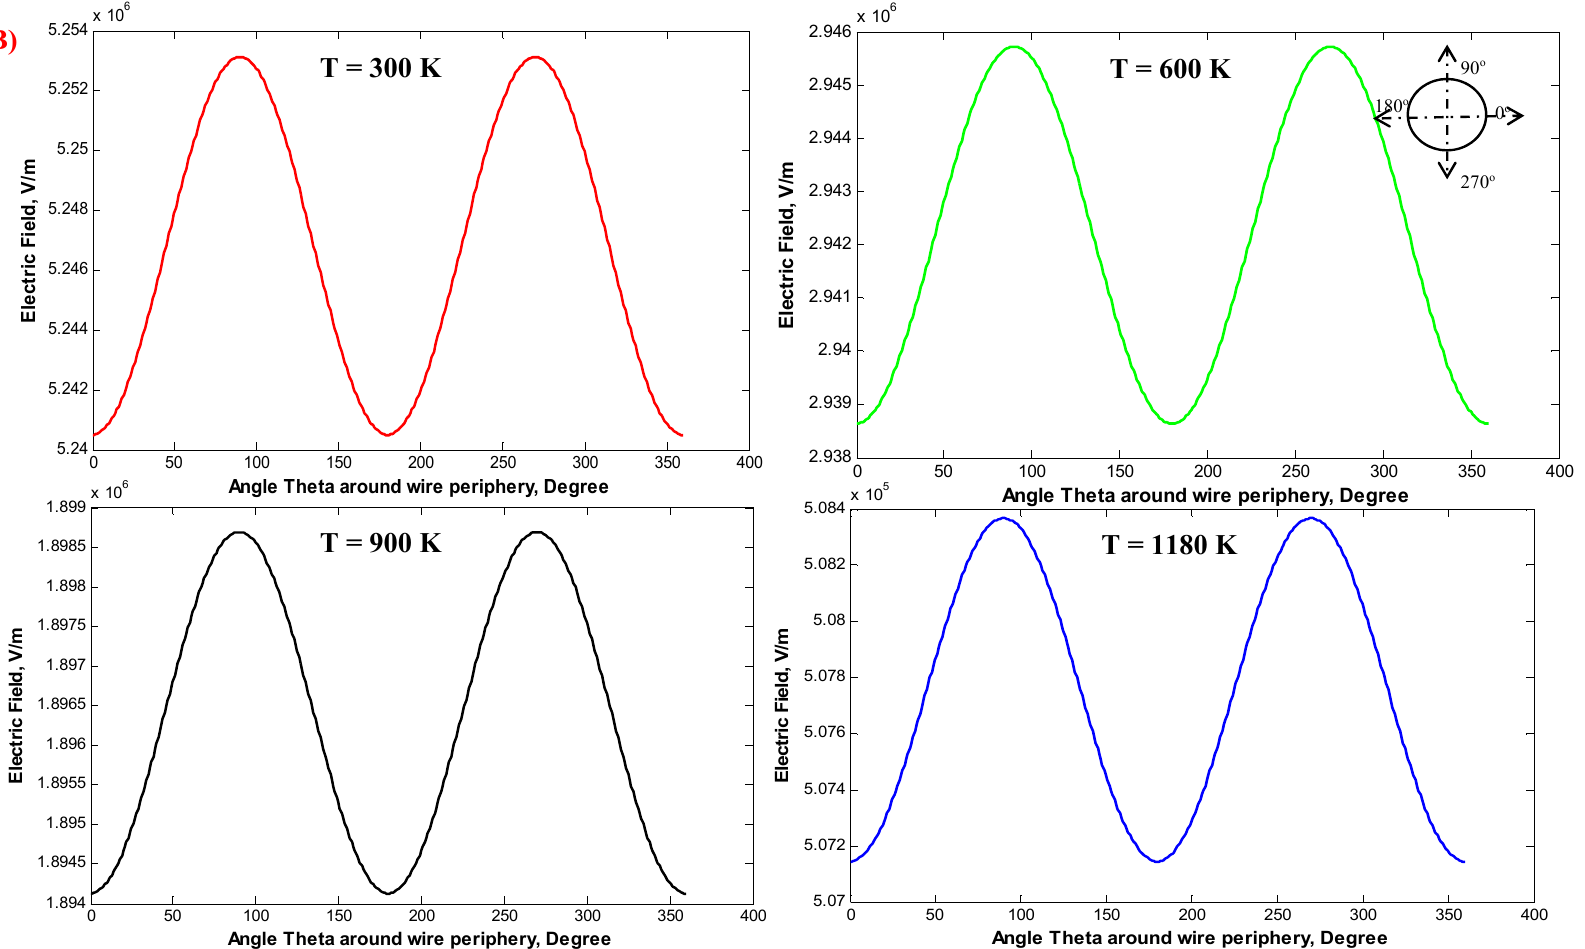
Figure 16. Distribution of the electrostatic field around the central wire of the multi-discharge wire WDESP (five-wire): ( A ) rc = 0.935 mm, Vo = 37.304 kV; and ( B ) rc = 1.975 mm, Vo = 58.933 kV.